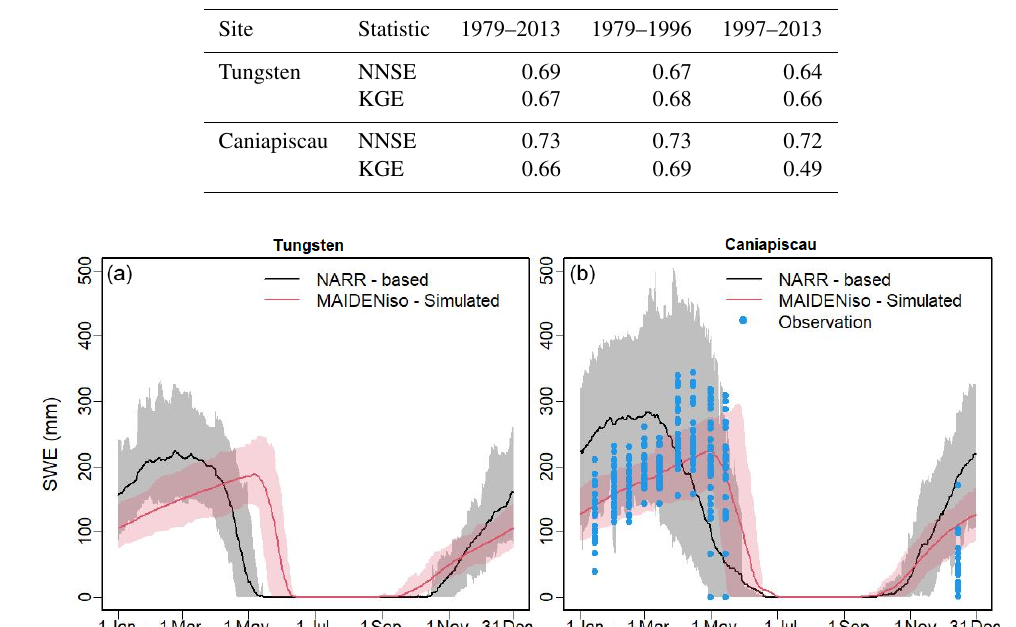
Table 3. Normalized Nash–Sutcliffe efficiency (NNSE) and Kling–Gupta efficiency (KGE) for the mean annual cycles of SNDP simulated by calibrating the model with the full period and the two half-periods, at the Tungsten and Caniapiscau sites.